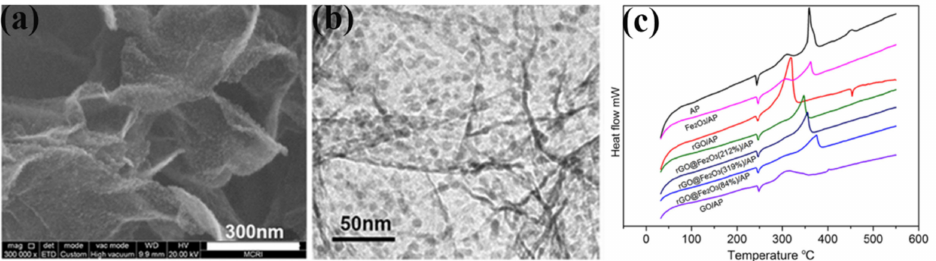
Figure 22. SEM images of ( a ) rGO@(84wt%)Fe 2 O 3 , and TEM images of ( b ) rGO@(84wt%)Fe 2 O 3 ; ( c ) DSC curves for the thermal decomposition of AP with different additives. ( a – c ) Reproduced with the permission of ref. [104]. Copyright 2018, Applied Surface